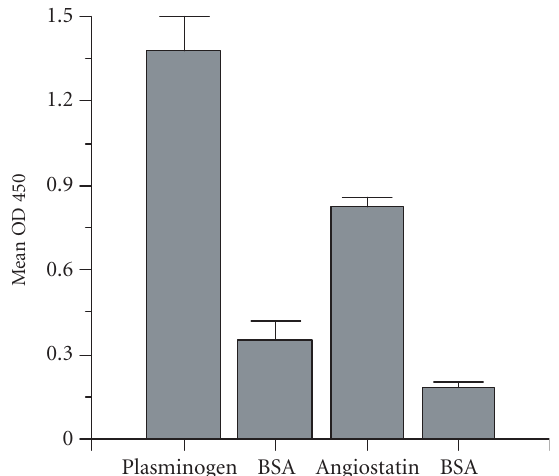
Figure 2. Tetranectin reduces binding of plasminogen to ECM deposited by endothelial cells. ECM of endothelial cells was pro- duced as described in “methods,” and binding of plasminogen was measured using ELISA. The e ff ect of tetranectin (wild type) on binding of plasminogen was assessed by preincubation of plasminogen with tetranectin (100nM) for 30 minutes at 37 ◦ C, followed by addition of these samples to wells coated with ECM. Results shown are mean ± SEM of 4 experiments (each exper- iment done in triplicate). Binding of plasminogen at 22.5 or 45 µ g/mL was significantly reduced by tetranectin ( P < . 05; in- dicated by ∗ ). Table 1. Binding of plasminogen and angiostatin, contain- ing kringles 1-4 or kringles 1-3 (AST K1-4 , AST K1-3 ), to